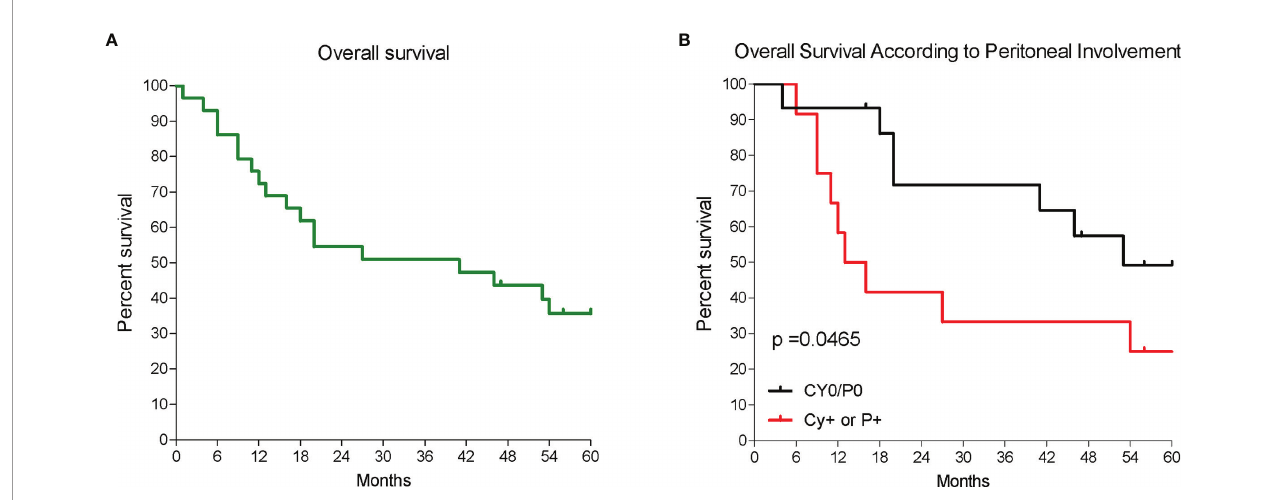
FIGURE 1 | Patients survival. (A) Overall survival of a cohort of patients with GC and (B) overall survival of 31 patients according to the presence of peritoneal disease either macroscopically or microscopically; p <